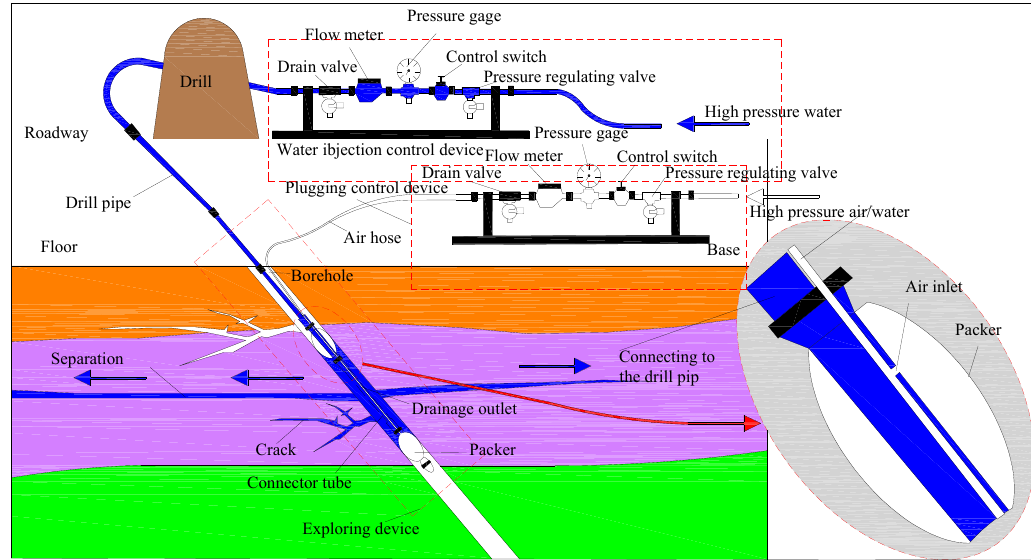
Figure 10. Diagram of an isolated borehole section flow testing system.